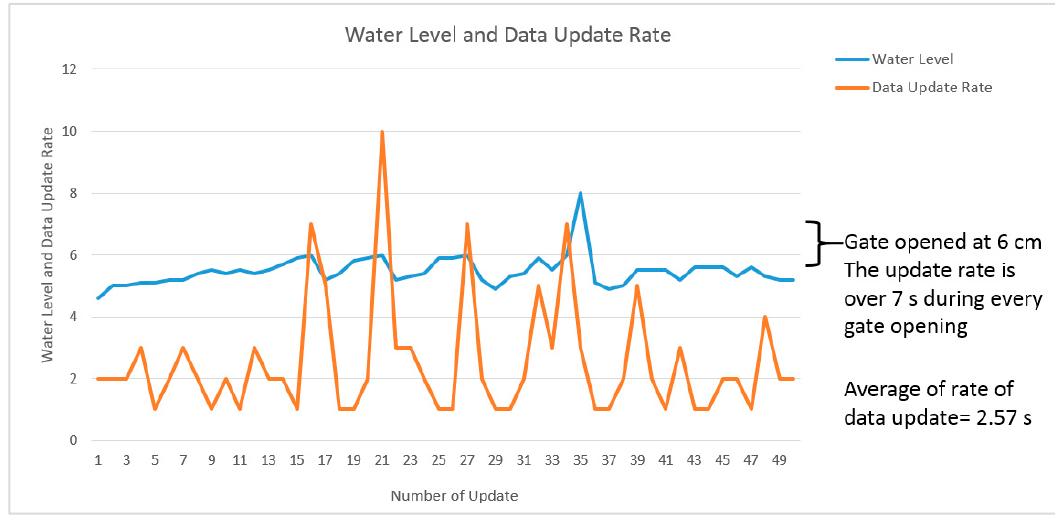
Figure 17. Gate V1 water level and data update rate.